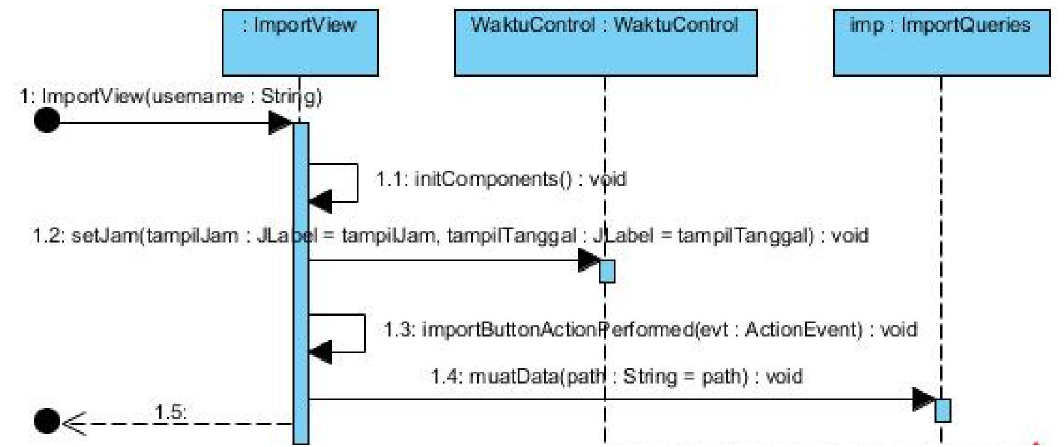
Gambar 4. Sequence diagram import